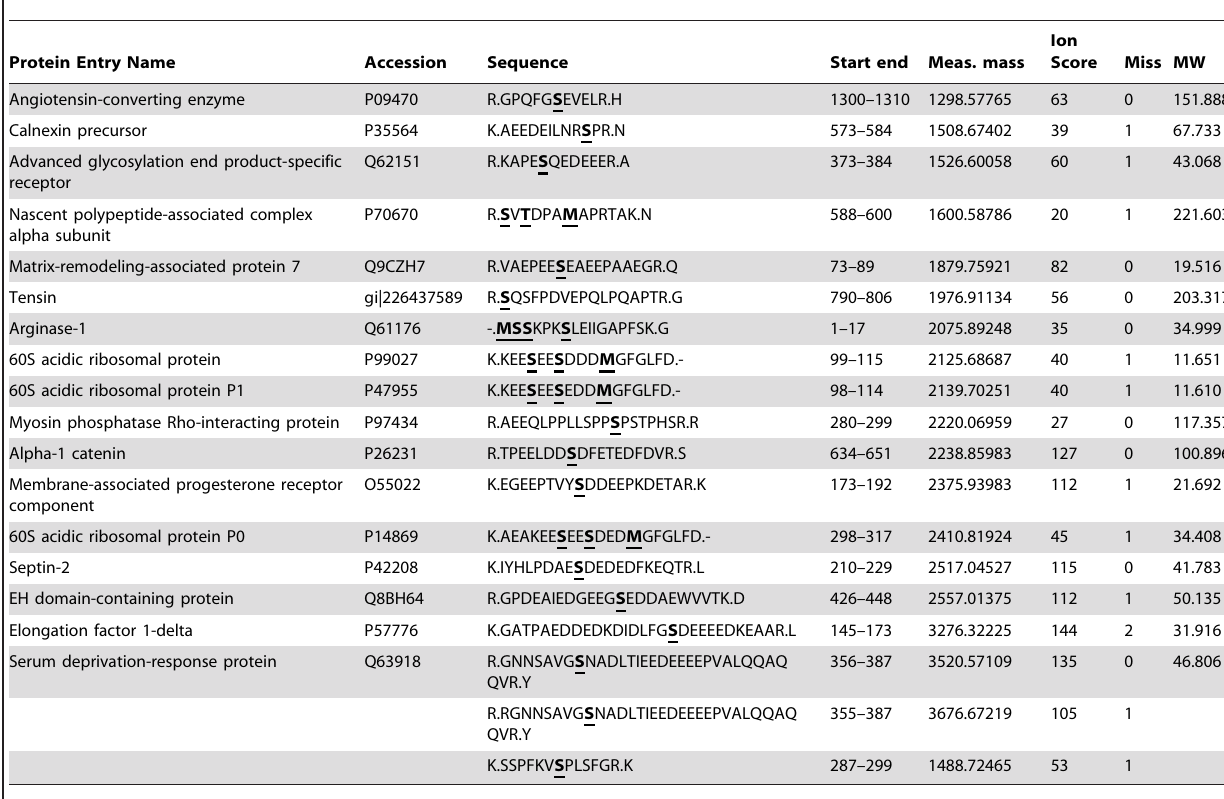
Table 1. Identified phosphopeptide by MALDI tandem MS using DHB ML sample